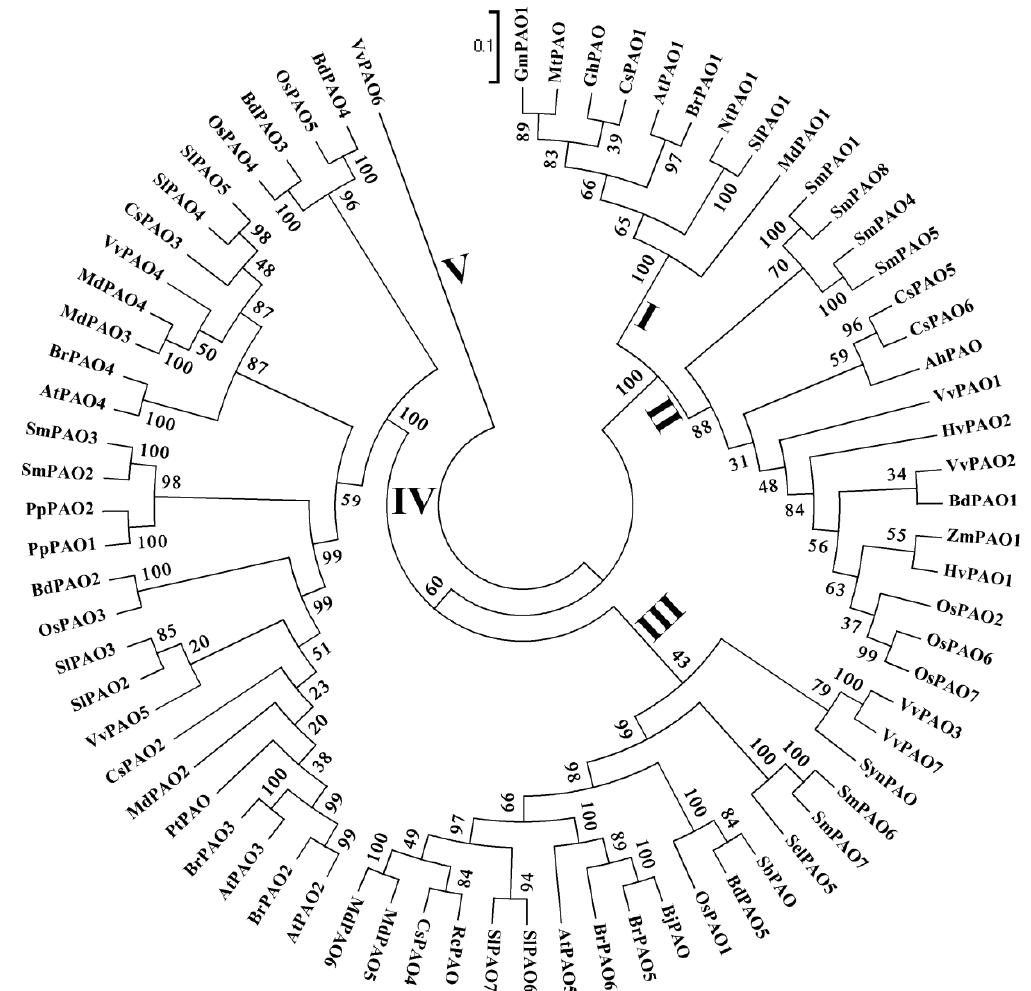
Figure 2. Phylogenetic relationship of polyamine oxidases (PAOs) among rice, Arabidopsis, tomato, and other plants. The neighbor-joining tree was constructed by amino acid sequence alignment using Clustal X 1.83 and MEGA 5.0. The bootstrap values, displayed at the branch nodes, were obtained with 1000 repetitions. Roman numerals (I~V) indicate clade numbers. The analyzed genes and their accession numbers are listed in Table 1. Os, Oryza sativa ; At, Arabidopsis thaliana ; Sl, Solanum lycopersicum